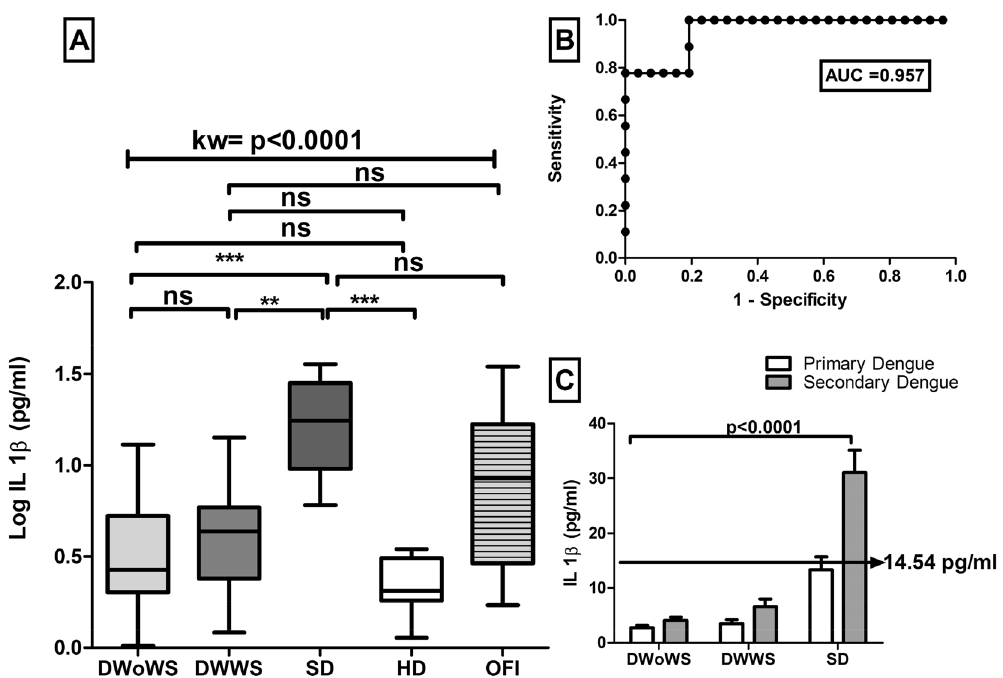
Figure 6. ( A ) Levels of IL-1β of dengue without warning sign (DWoWS), dengue with warning signs (DWWS), severe dengue (SD) and Other febrile infection (OFI). Study subjects are significantly different from each category. ( B ) Receiver operating characteristics curve analysis obtained the AUC = 0.957. ( C ) Levels of IL-1β of primary and secondary dengue infection. Arrow line showing the severity cut ‐ off value (14.54 pg/mL) obtained from the Youden index. Study subjects are significantly different from each category is indicated by P < 0.05. AUC, area under the curve; HD, healthy donors. Statistical analysis was performed using the Graph-Pad